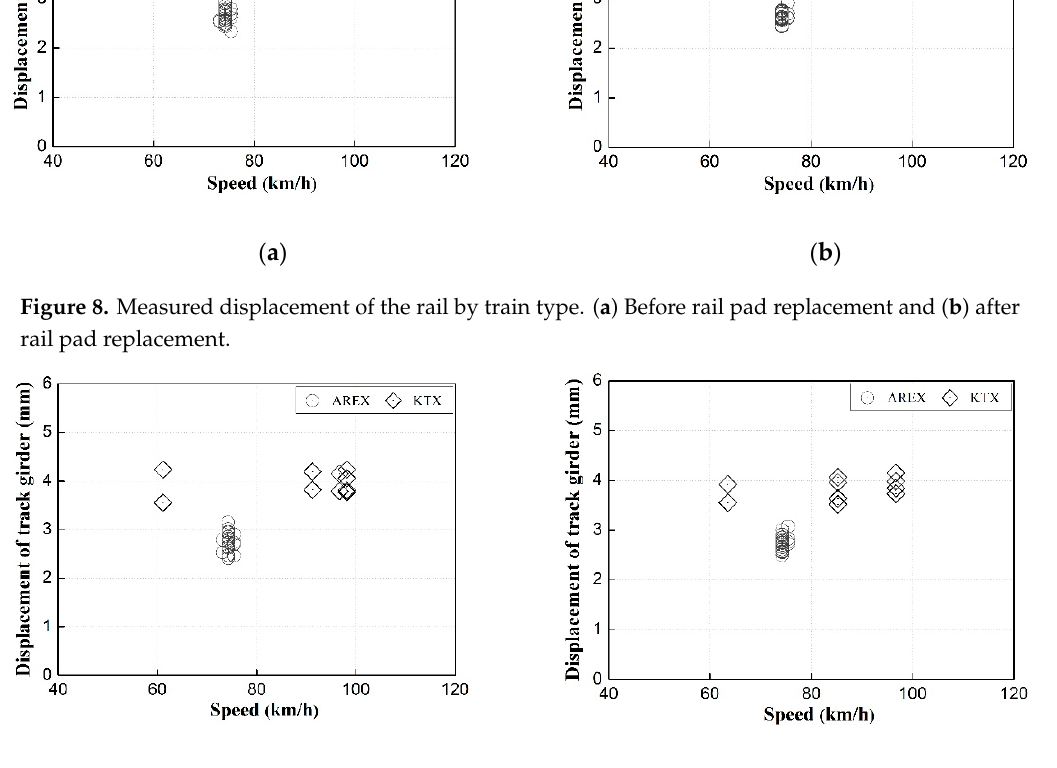
Figure 8. Measured displacement of the rail by train type. ( a ) Before rail pad replacement and ( b ) after rail pad replacement.